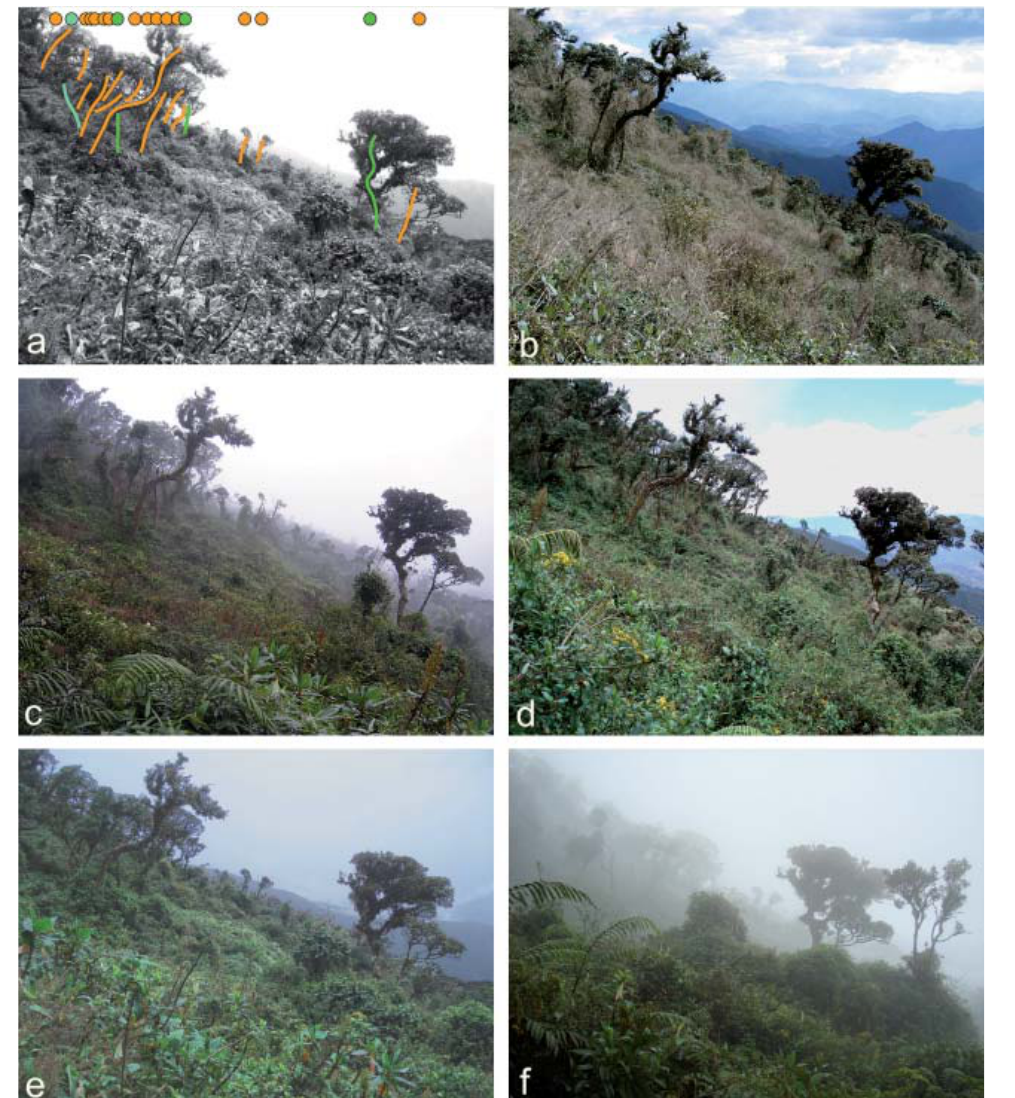
Figure 17: Cohort mortality of Chusquea scandens (b) and subsequent plant succession of herbaceous and shrubby pioneers (c-f) at about 3,080 m a.s.l. in Cajanuma. 14 inclined trees marked by orange lines indicate the debris creeping effect, while 4 (green) apparently are not affected by the slow mass move- ment process (a). Photo+s b-f were taken between October 2004 and 2008 (photos: M.